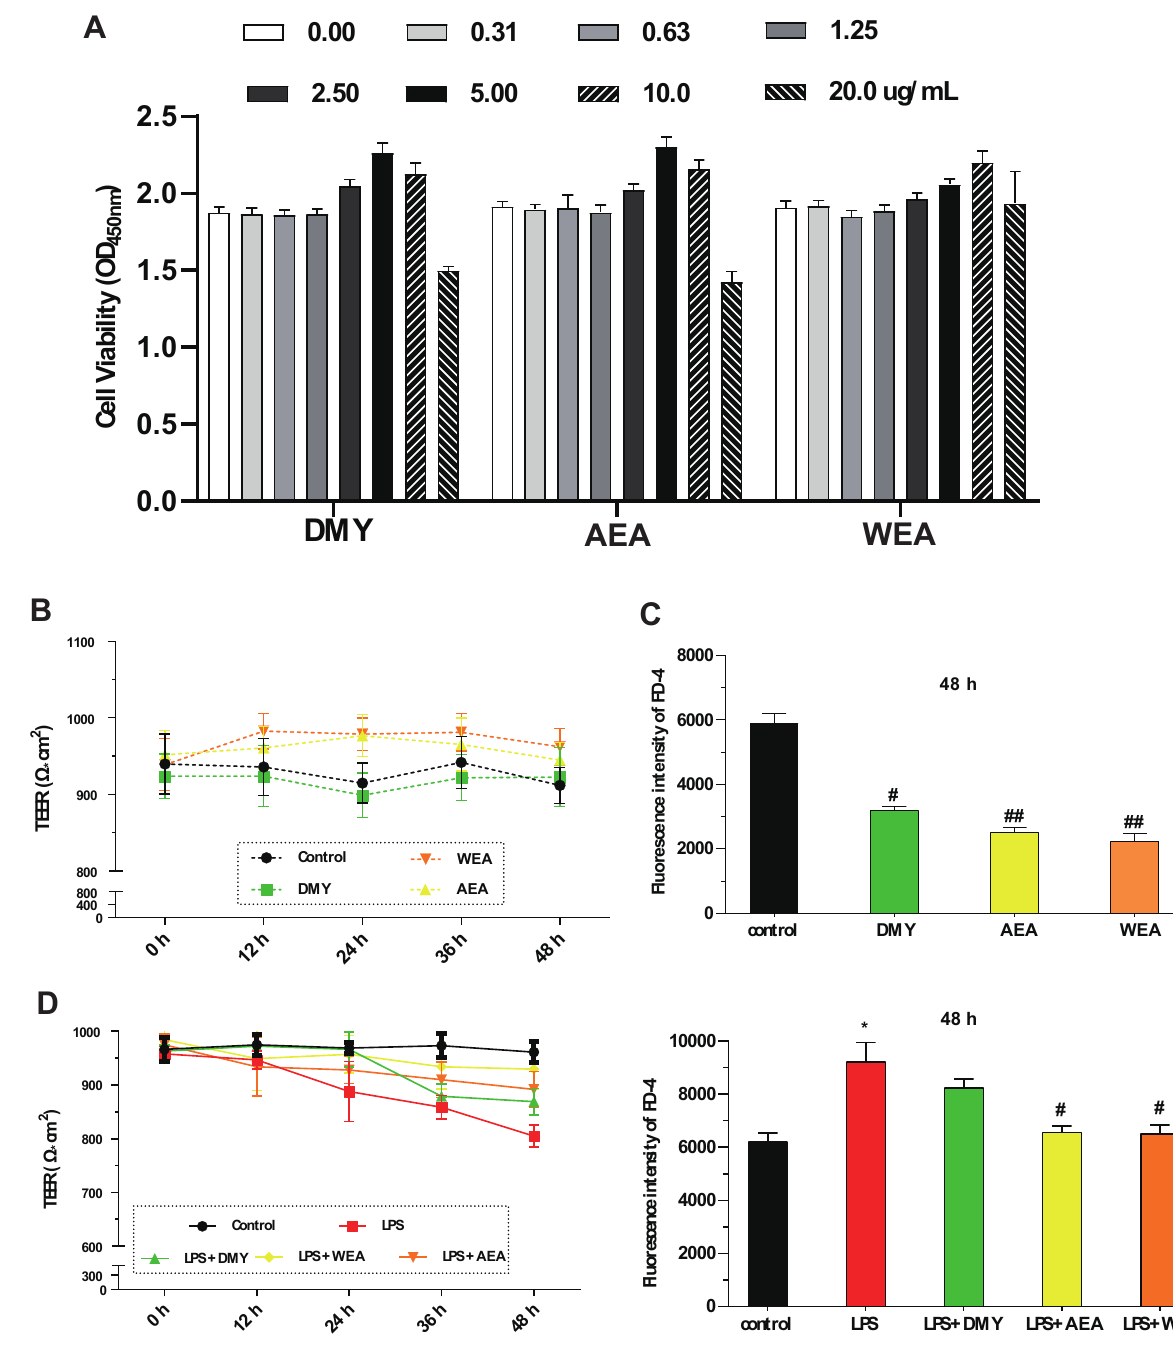
Figure 2. Effects of DMY, AEA, and WEA on the intestinal barrier function, as determined based on IPEC-J2 cells. Effects of DMY, AEA, and WEA on IPEC-J2 ( A ) cell viability, ( B ) transmembrane resistance (TEER), ( C ) permeability (FD-4 leakage), and ( D ) TEER value ( D , left) and FD-4 leakage ( D , right) when using LPS to simulate inflammatory injury in cell monolayers. All values are ex- pressed as mean ± SEM. Compared with control * p < 0.05. Compared with LPS, # p < 0.05, ## p < 0.01. DMY = 5 µ g/mL dihydromyricetin ( purity > 90%); AEA= 5 µ g/mL alcohol extract of A. grossedentata (total flavonoid content > 82%); WEA = 10 µ g/mL water extract of A. grossedentata (total flavonoid con- tent > 57%); LPS = 5 µ g/mL lipopolysaccharide; LPS + DMY = 5 µ g/mL dihydromyricetin + 5 µ g/mL lipopolysaccharide; LPS + AEA = 5 µ g/mL alcohol extract of A. grossedentata + 5 µ g/mL lipopolysac- charide; LPS + WEA = 10 µ g/mL water extract of A. grossedentata + 5 µ g/mL